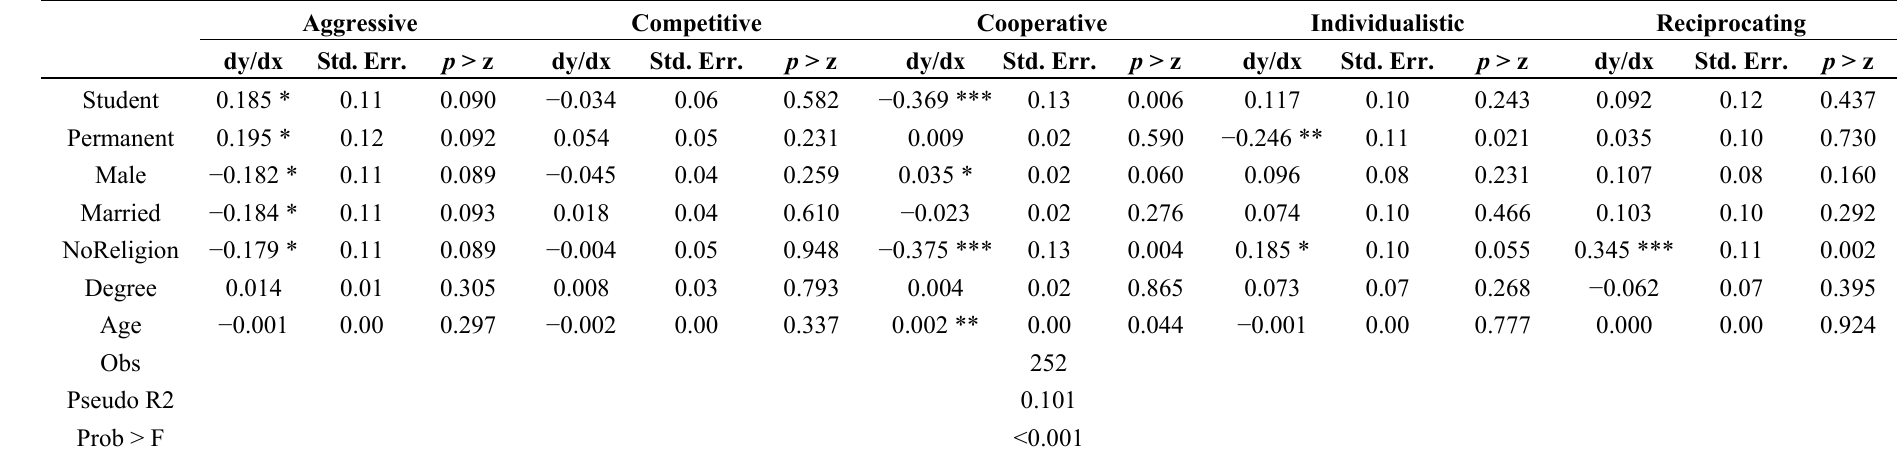
Table 6. Multinomial logit